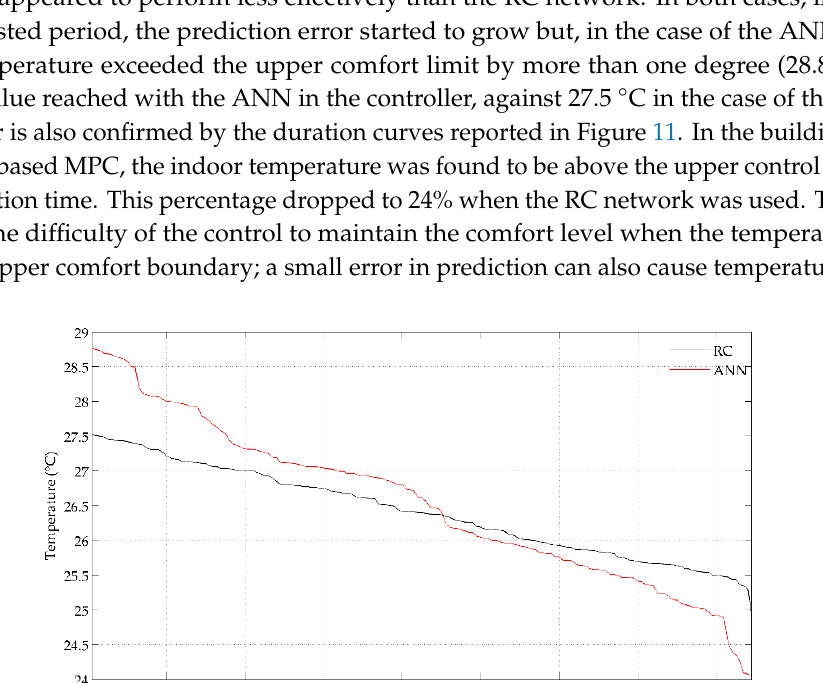
Figure 11. Indoor air temperature duration curves.